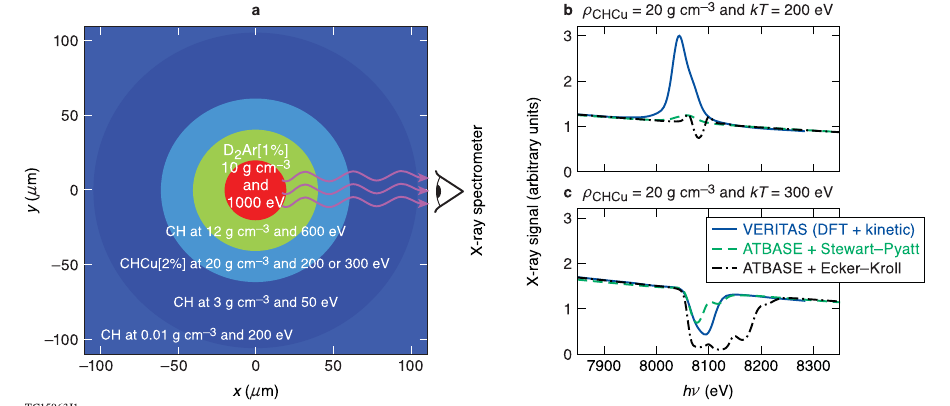
Fig. 1 | Illustration ofpredictedspectroscopicdifferences for warm-/hot-dense plasmas by different atomic physics models. a Schematic of a surrogate dense- plasma object consisting of a Cu-doped CH plasma layer for spectroscopy. b The predicted K α emission signal from the doped Cu layer of mass density of ρ =20gcm − 3 and kT=200eV, by three different models: VERITAS (blue solid),